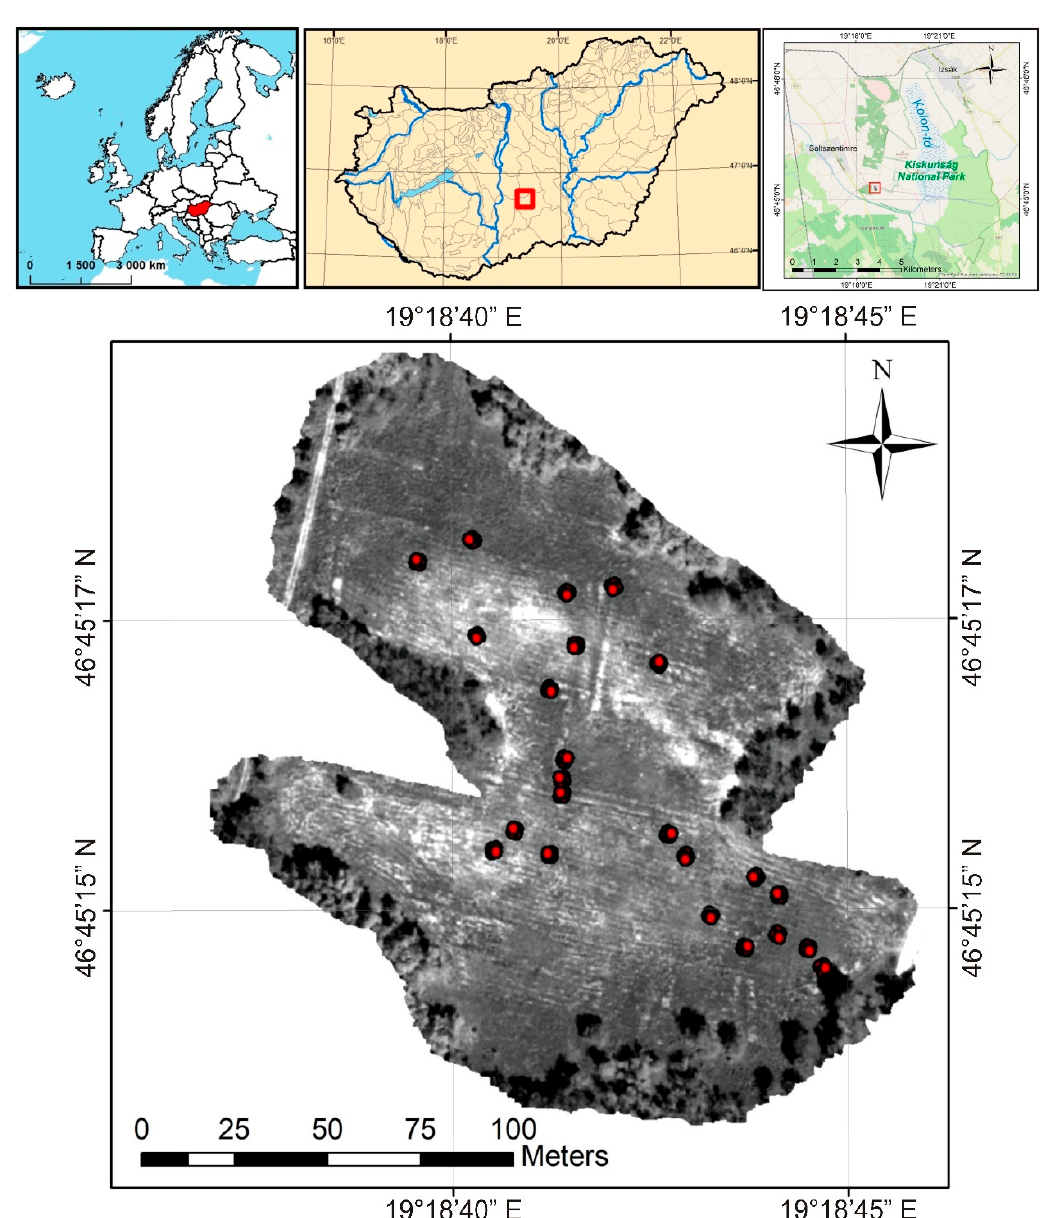
Figure 2. Location of the target plot in the Southern Great Plain region (on the Kiskunság Sand Ridge), on the outskirts of the village of Soltszentimre: the area of 2 ha is considered as the study site with 23 sampling quadrats.